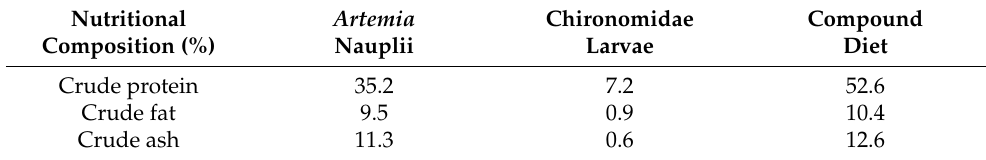
Table 1. Main nutritional components of diets.